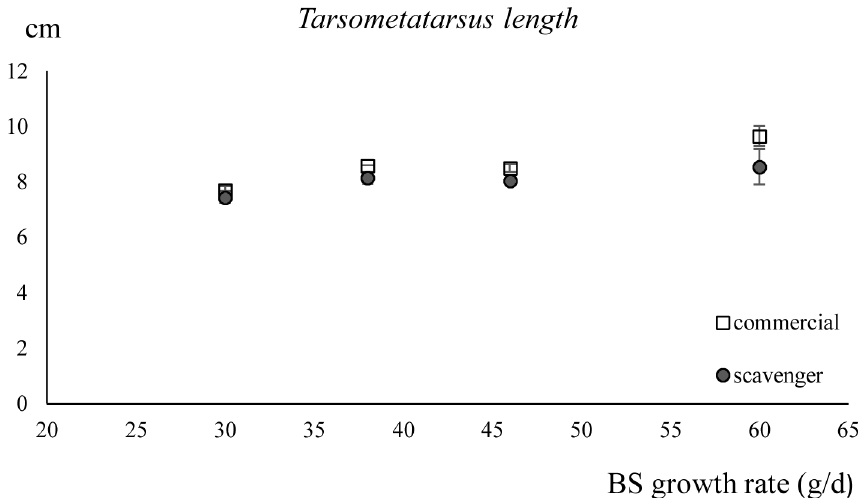
Fig 5. The length of the tarsometatarsus ( ± standard deviation) of chickens fed the scavenger or the commercial diet in function of their breed-specific (BS) growth rates. BS growth rates: 60g/ d (Cobb), 46g/ d (CobbSasso), 38g/ d (Sasso) and 30g/ d (Sussex).